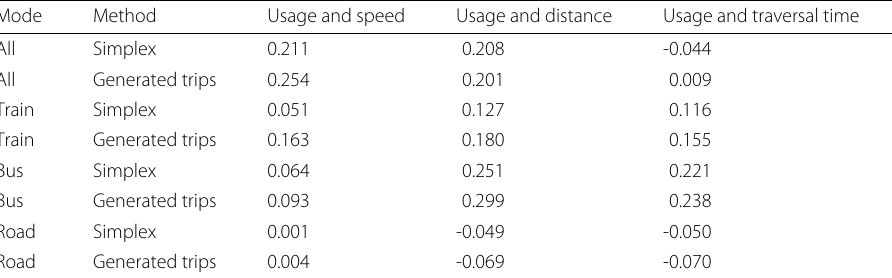
Table 6 Characteristics of the trip data related to mode usage, total distance, and circuity Mode Method Usage and speed Usage and distance Usage and traversal